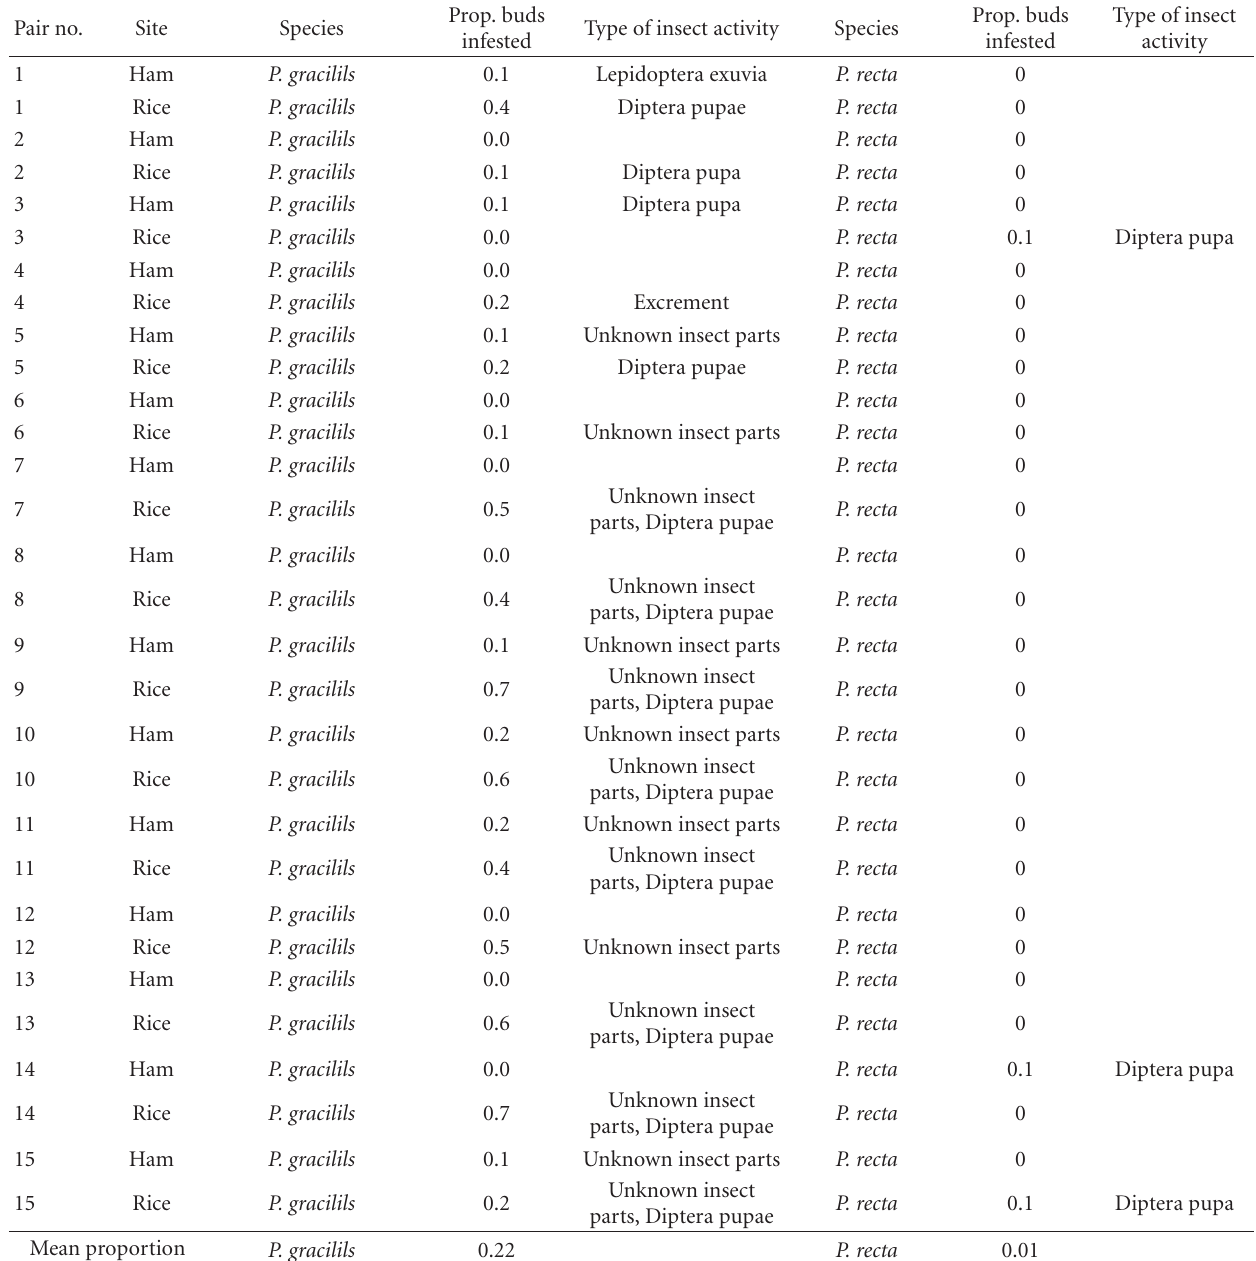
Table 6: Proportion of cinquefoil buds ( N = 10) within which evidence of insect activity was observed, for 15 paired samples of Potentilla gracilis and P. recta , at Ham and Rice sites, June, 2004. Pair